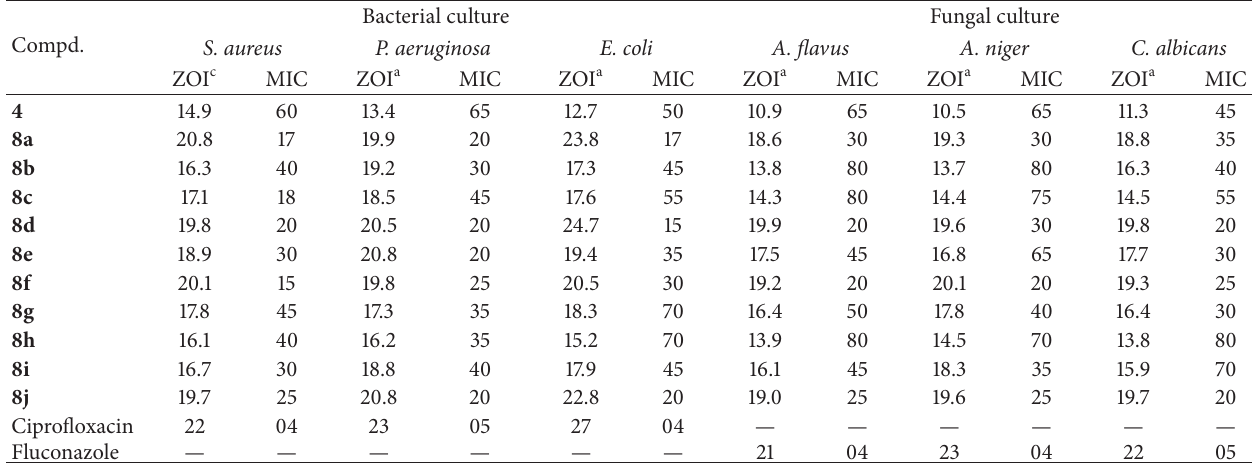
Table 4: Antimicrobial activity of the titled urea and thiourea derivatives 8(a–j) .